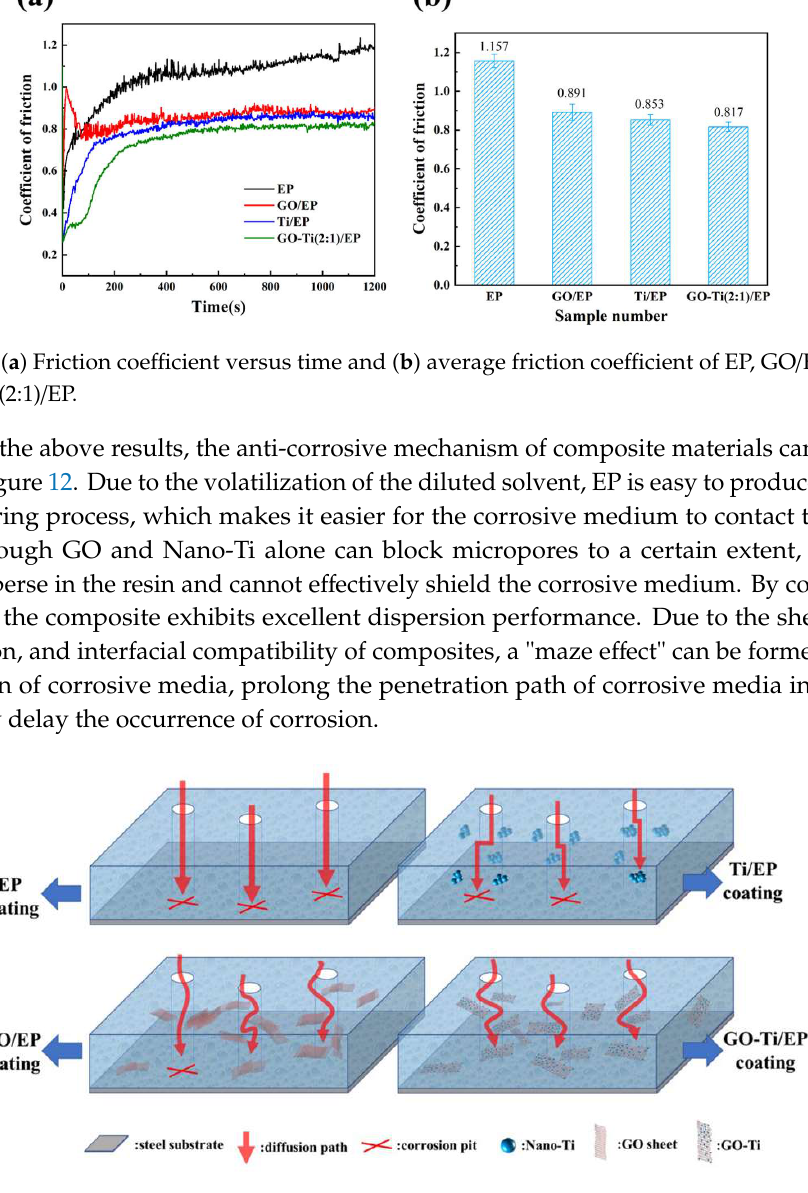
Figure 12. The anti-corrosion mechanisms of GO-Ti / EP composite coatings.